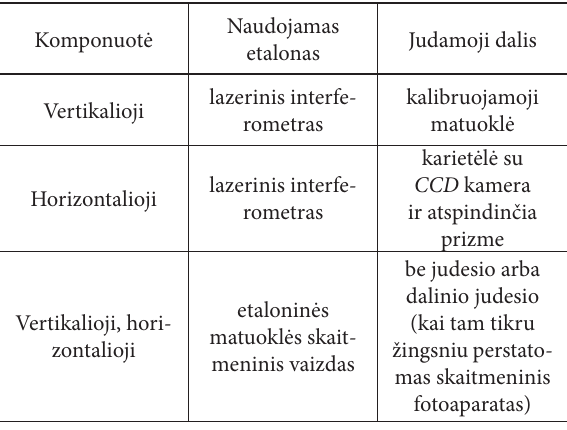
Table 1 . The principal structure of comparators